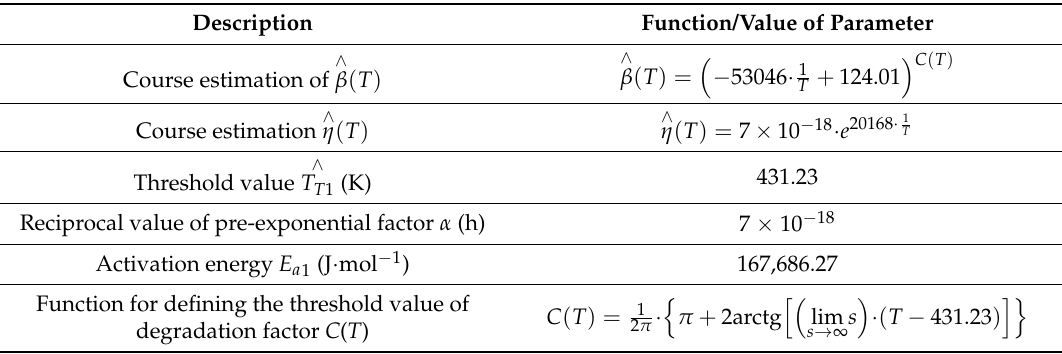
Table 3. Calculated parameters and estimated functions of probabilistic model.